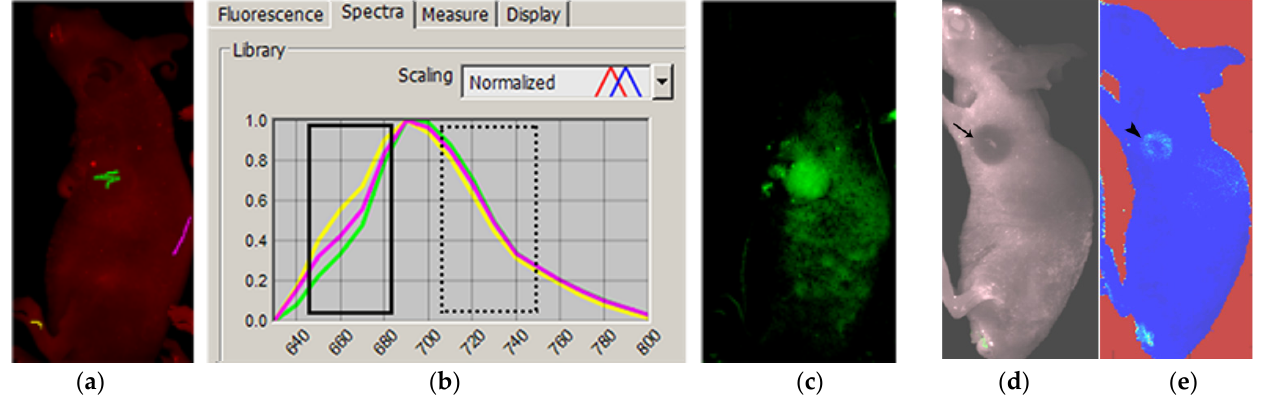
Figure 1. Hyperspectral data, fluorescence only, and an augmented image from parameters for auditory display. Fluorescence images were acquired under an emission filter setting from 640 to 800 [nm] in 10 [nm] increments. Hyperspectral data were overlaid on grayscale photographs to identify the ROI ( a ). Markers placed on ROIs obtained the pattern of the hyperspectral data ( b ). Spectral unmixing and overlay of the unmixed data on the grayscale images showed the tumor area with the accentuated NIRF spectrum, confirming the tumor uptake of the NIRF probe ( c ). Tumor without visible NIRF uptake on fluorescence only ( d ) was shown to have signal aided by data for auditory display ( e ).